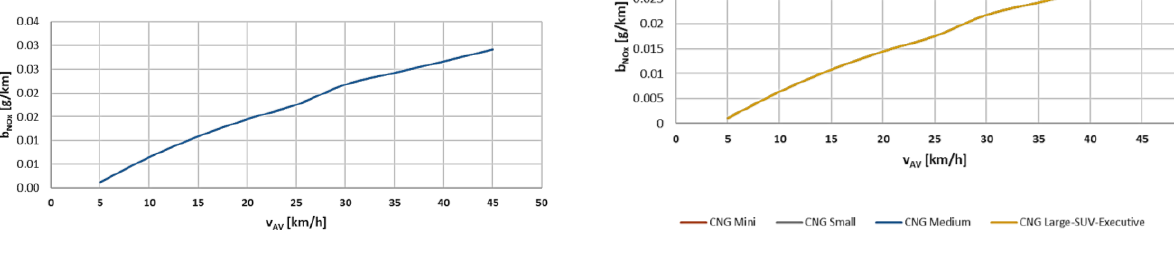
Fig. 18. NO x emission from CNG PCs for vehicle segments depending on average